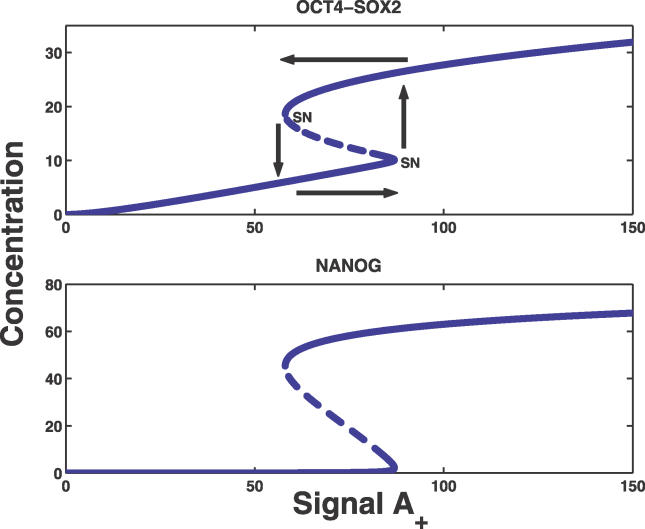
Steady State Behavior of the OCT4–SOX2 and NANOG Concentration Levels as Functions of the Signal A
+
There are two turning points (saddle-node bifurcations are marked as SN, and the dotted line connecting the SNs indicate unstable states) leading to a hysteretic curve. The arrows indicate how to interpret the hysteresis curve. As A
+ is increased beyond A ≈ 87 (arbitrary units), the system switches on, and thereafter as the stimulus is decreased below A ≈ 58, the switch turns off. The on/off states refer to high/low levels of OCT4, SOX2, and NANOG.